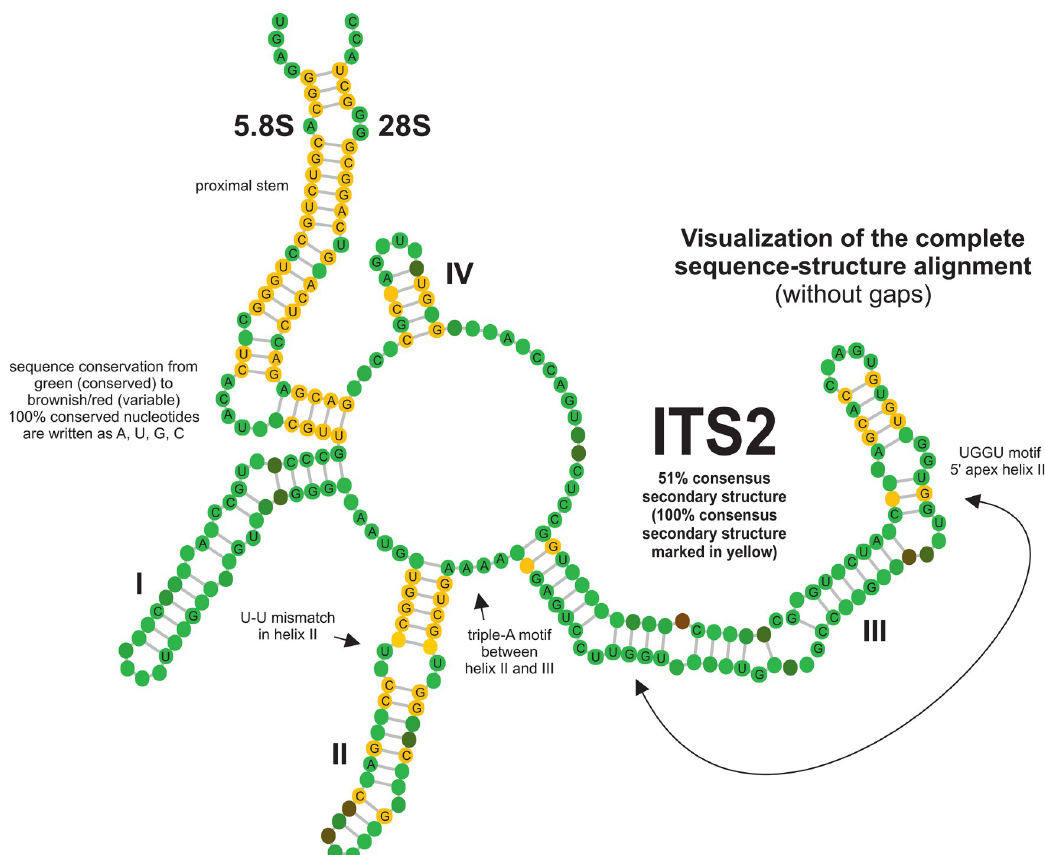
Fig 5. ITS2 consensus secondary structure scheme, with 100% conserved positions through the